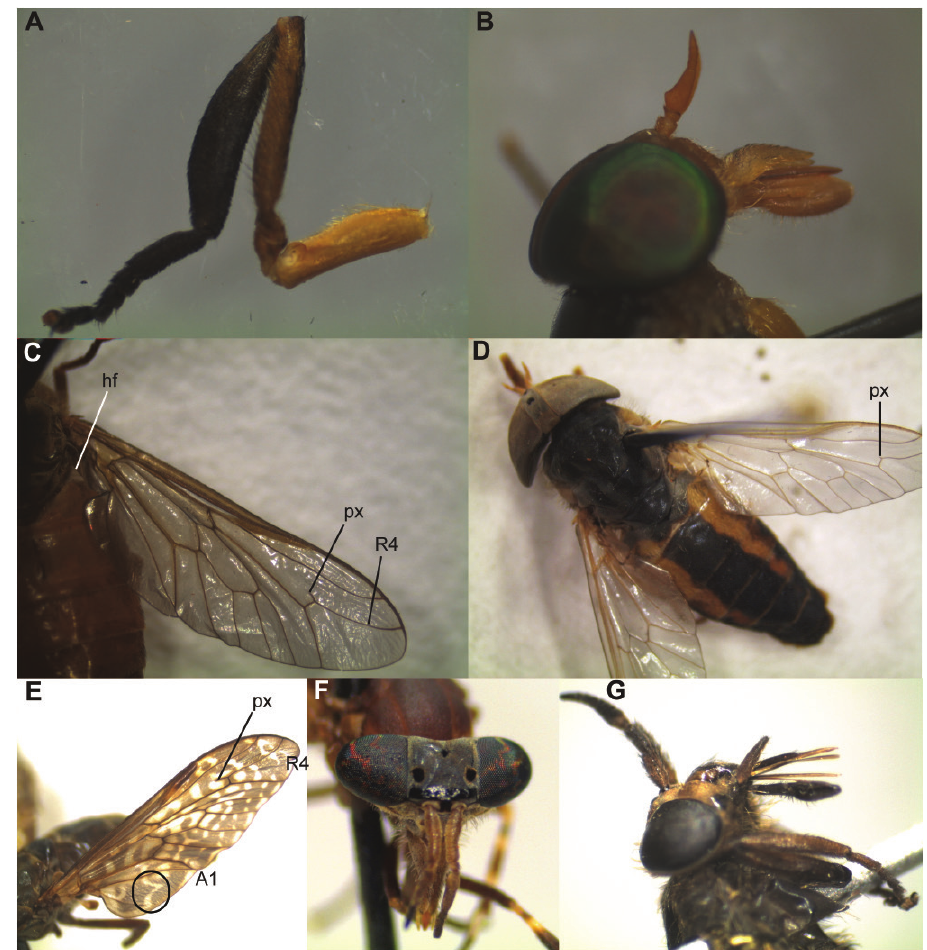
Figure 4. Key morphological features of sampled tabanid species . A Ancala fasciata B Tabanus donaldsoni green eyes (in fresh sample) C Tabanus donaldsoni, wing with distinct R4 appendix (px), indistict hair tuft (hf) D Atylotus nigromaculatus, wing with short, clear appendix on R4 E Haematopota duttoni, mottled wing with a right angled white thick line (in black circle) between vein A1 and the wing margin, the R4 has a long appendix F Haematopota fenestralis, shiny black callus on frons, eyes have bright coloured bands G Chrysops brucei , lateral view of head showing the antenna, black mouth parts and brown legs